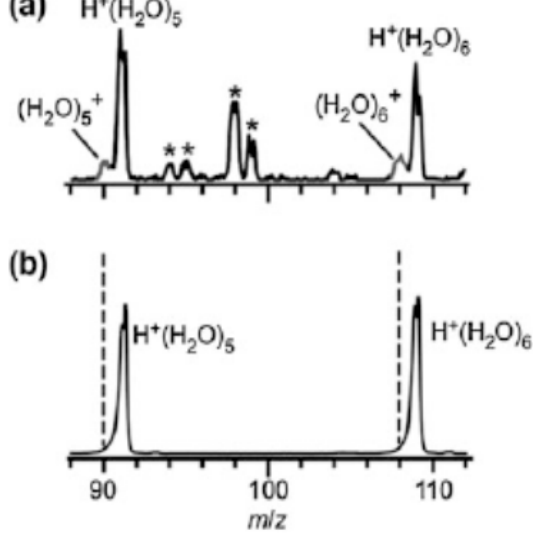
Figure 15. Cluster ion distributions obtained with ( a ) a “colder” cluster ion source and ( b ) “warmer” cluster ion source. Figure adapted from [15] with permission. Copyright 2011 The Royal Society of Chemistry.